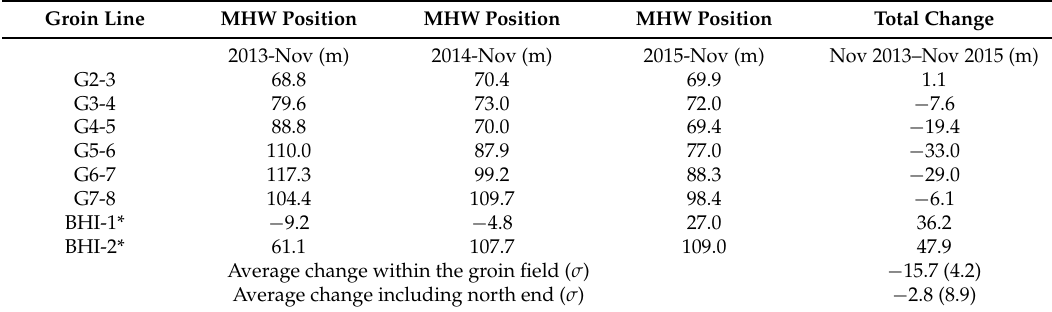
Table 2. MHW shoreline positions* measured at within each groin cell and changes from construction completion (November 2013) to November 2015. *MHW positions measured from the MHW survey plan view (Figure